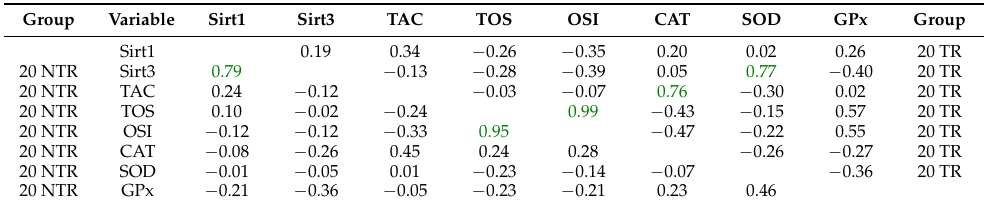
Table 6. Correlations between the concentrations of sirtuins and prooxidative–antioxidant balance markers in young training and non-training men. Group